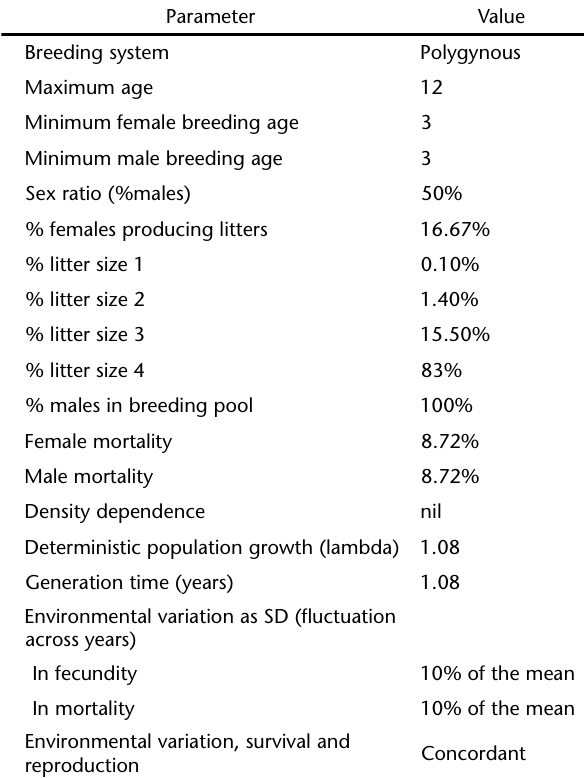
Table I. Biological and ecological attributes of the long-furred woolly mouse opossum M. paraguayanus used as input to Vortex, with a time step of two